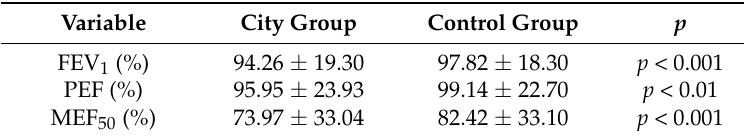
Table 4. Mean values and standard deviations of the percentages of predicted values of basic spirometric parameters in the city and control group.